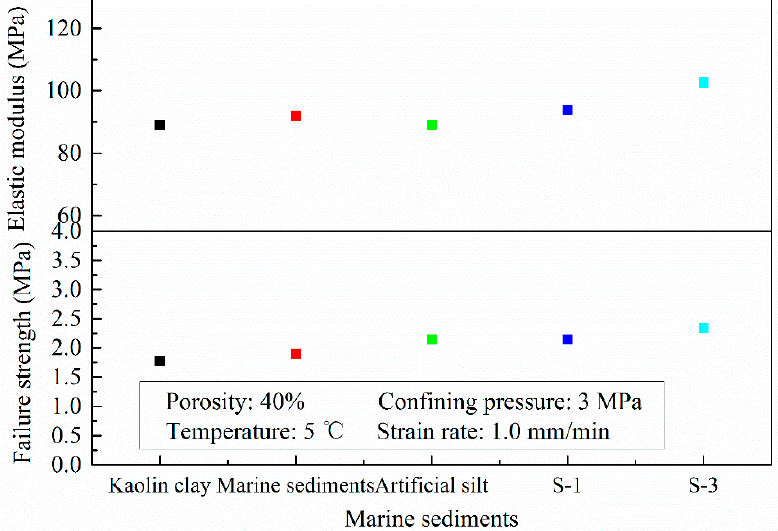
Figure 8. Elastic modulus and failure strength of HBMS, hydrate-bearing artificial silt and hydrate-bearing kaolin clay.